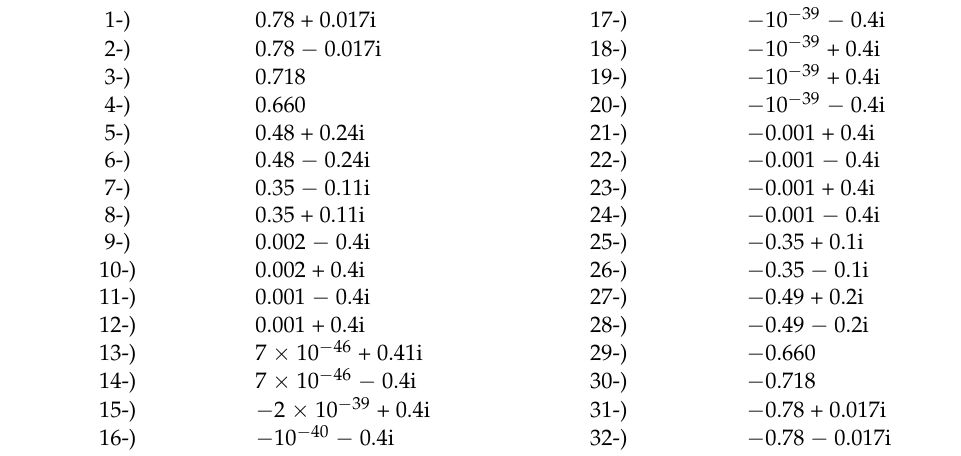
Table 3. Roots of the polynomial in Equation (33).